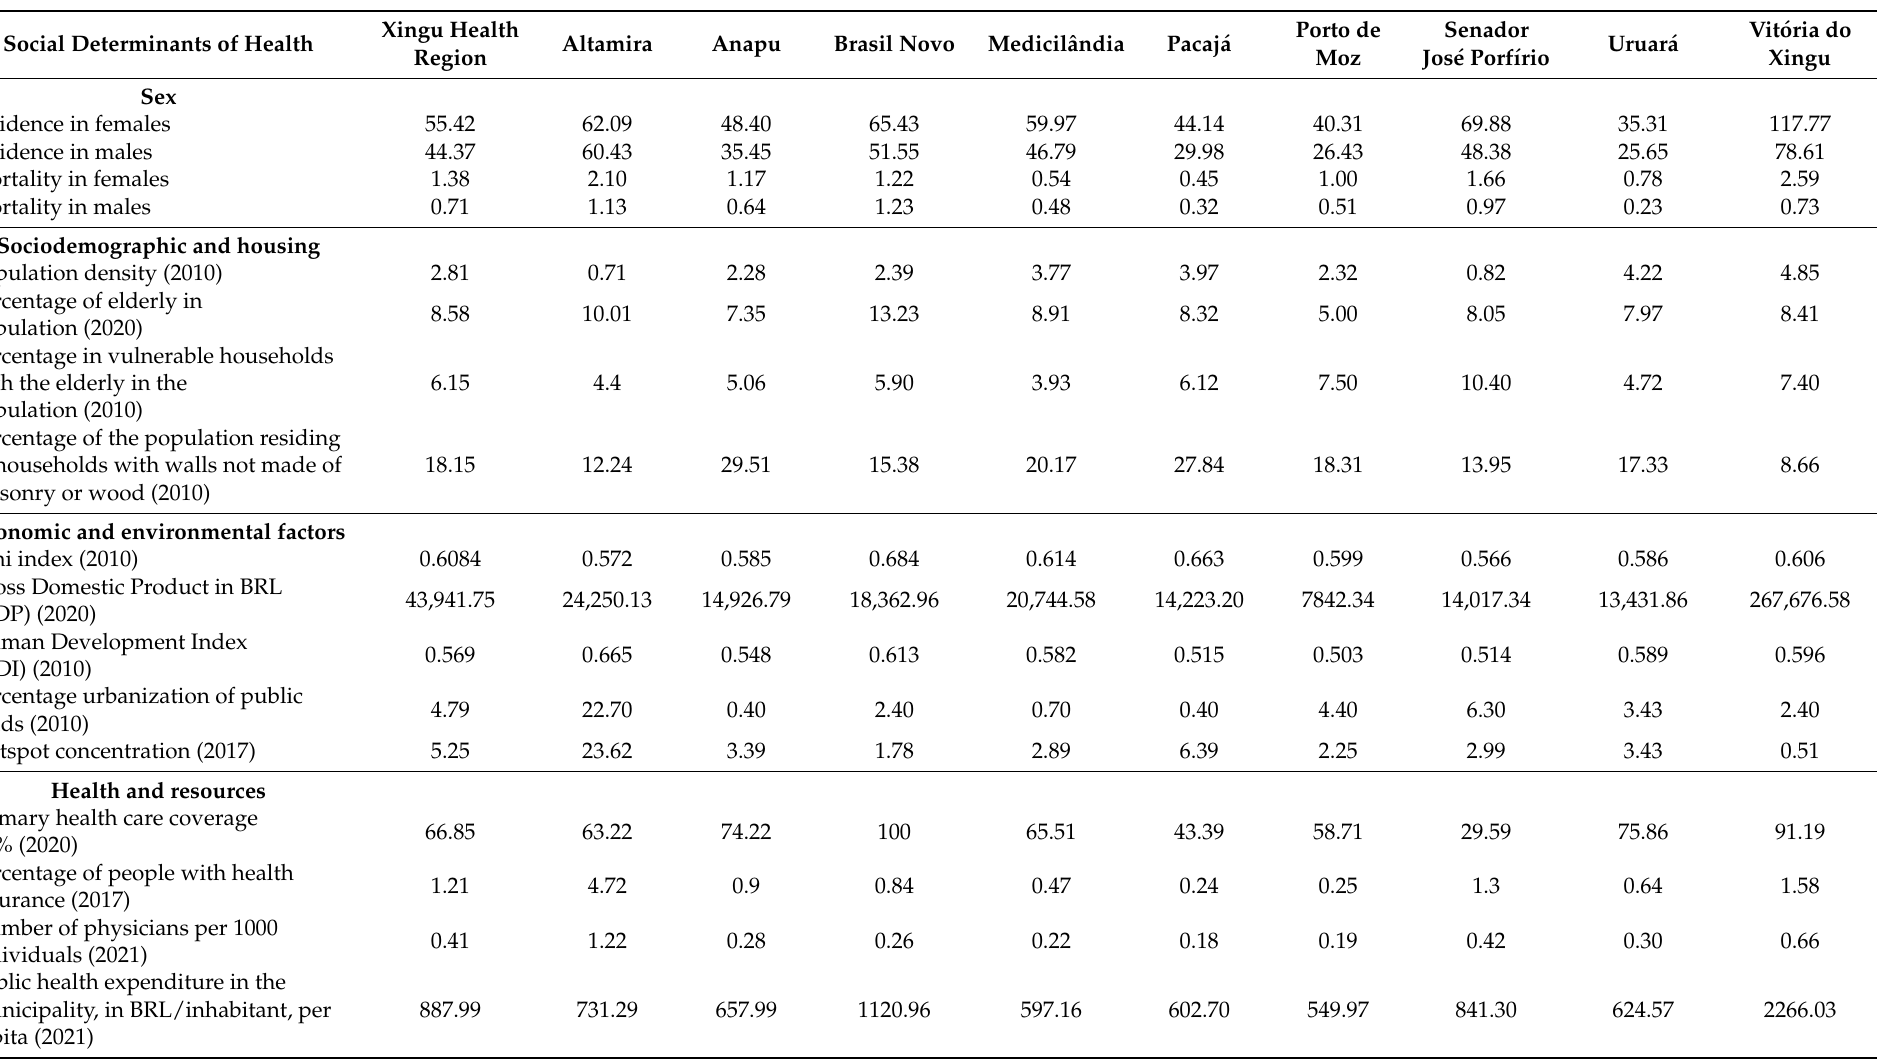
Table 1. Exploratory analysis of SDH indicators in the study of incidence and mortality by COVID-19 in the Xingu Health